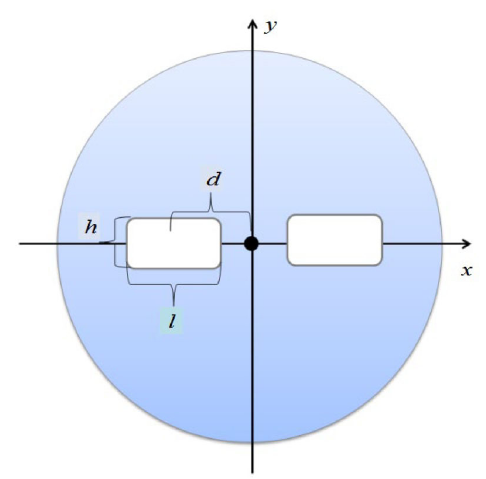
Fig. 4 Cross-section schematic of the rectangular-core side-hole